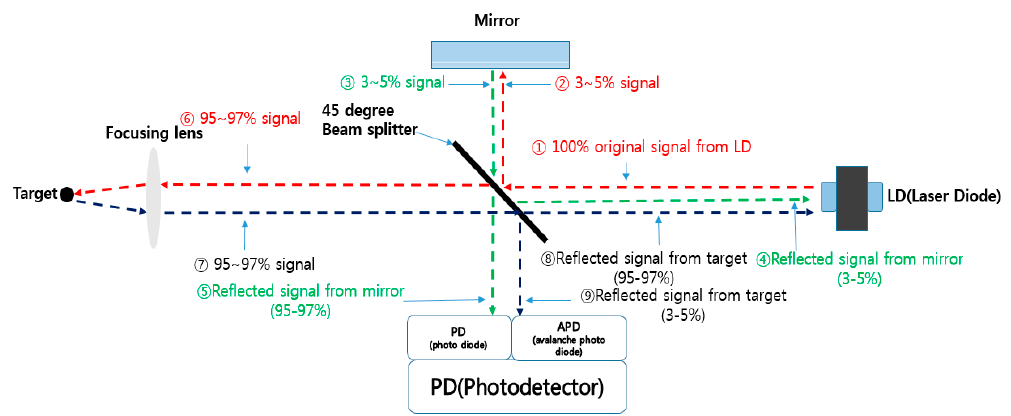
Figure 1. Basic principle of the laser displacement meter (LDM).